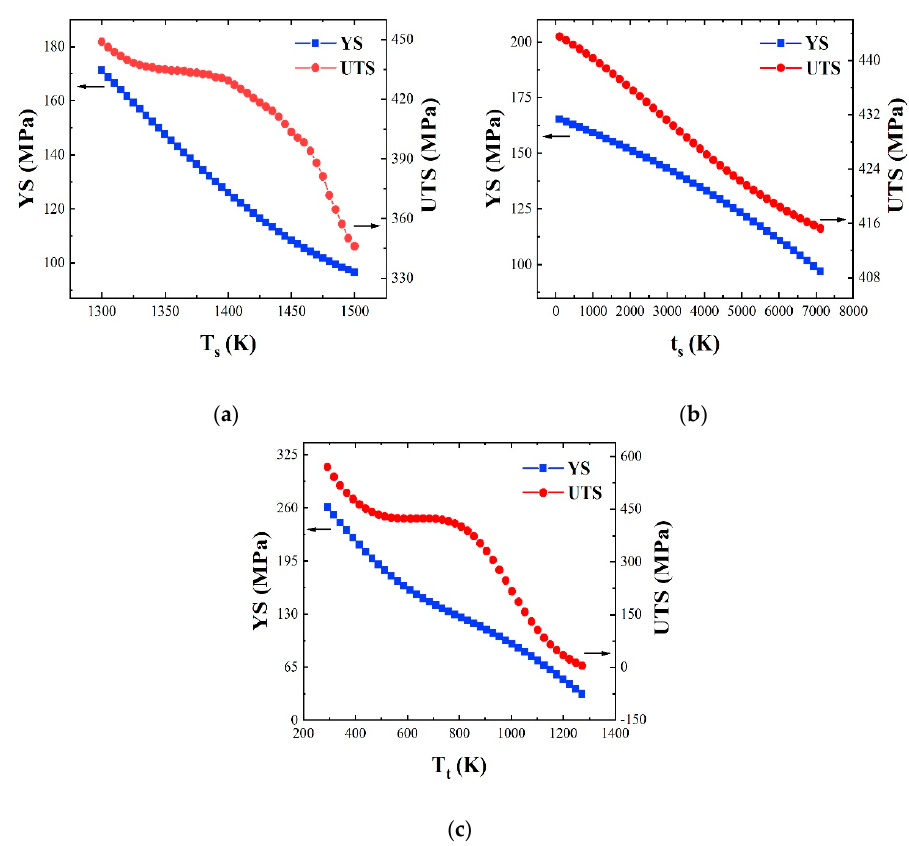
Figure 8. The predicted influence trends of ( a ) temperature, ( b ) time of solution treatment and ( c ) test temperature on YS and UTS. The blue and red dots represent the predicted values of YS and UTS respectively.